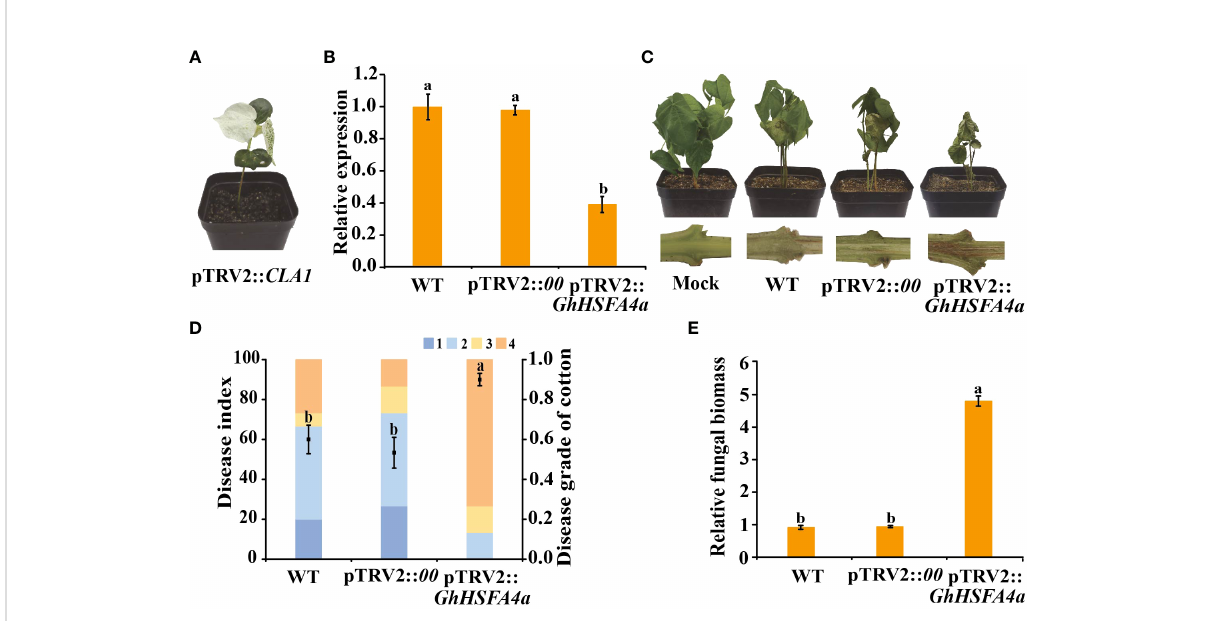
FIGURE 4 Silencing of GhHSFA4a attenuates plant resistance to V. dahliae . (A) Phenotype of pTRV2:: CLA1 at 14 days post Agrobacterium in fi ltration. (B) Expression of GhHSFA4a in pTRV2:: GhHSFA4a and control plants. UBQ was the internal reference gene (2 - DD Ct ). (C) Disease phenotypes of GhHSFA4a -silenced plants at 15 dpi with V. dahliae strain V991. (D) Disease index of pTRV2:: GhHSFA4a and control plants at 15 dpi with V. dahliae . (E) Fungal biomass determined using qRT-PCR at 15 dpi with V. dahliae . Error bars represent the standard deviations and different letters indicate signi fi cant differences at p